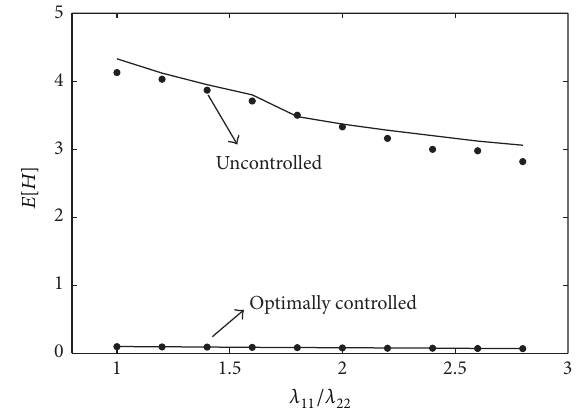
Figure 7: Mean value 𝐸[𝐻] of total energy of uncontrolled and optimally controlled system (40) as functions of the ratio 𝜆 11 /𝜆 22 . Thelinesareobtainedfromnumericalsolutionof(44)whilethedots are obtained from direct simulation of original system (40).